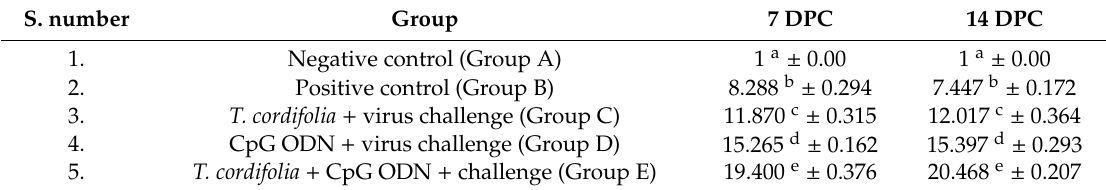
Table 5. Quantitative real time PCR analysis of IL-4 expression in PBMCs of chickens challenged with vvIBDV at di ff erent DPC.